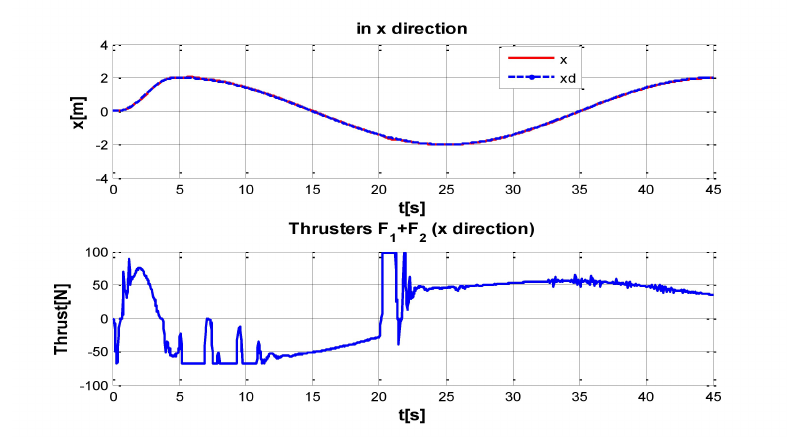
Figure 5. Behavior of the system in x-coordinate with perturbations up and (down) control signal of thruster F1 + F2.